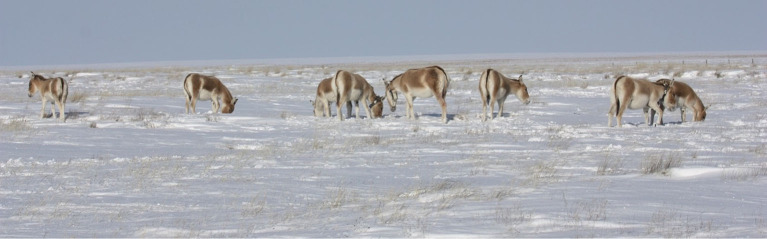
Translocated kulan digging snow to feed on the natural pasture in the acclimatization enclosure in Alibi in January 2018. Photo: D. Gliga and N. Petrova.